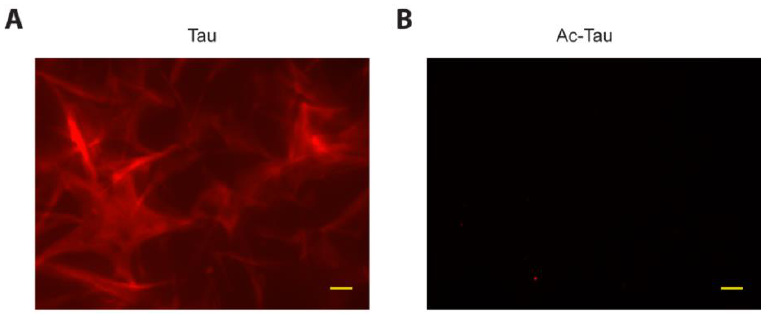
Figure 4. Tau acetylation prevents access to LLPS-mediated microtubule assembly. ( A , B ) Fluorescence microscopy images showing microtubule assembly from mixtures of rhodamine-labeled and unlabeled tubulin heterodimers with Tau or Ac-Tau, respectively. Scale bars represent 10 µ m. See Section 3 for details.